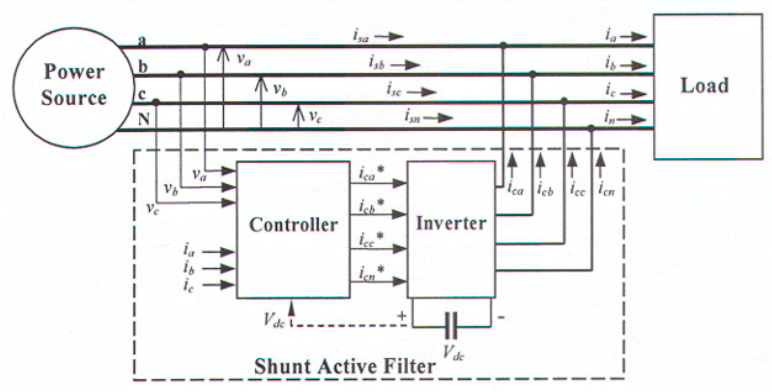
Figure 1. A schematic of a shunt active filter in a three-phase power system [30].